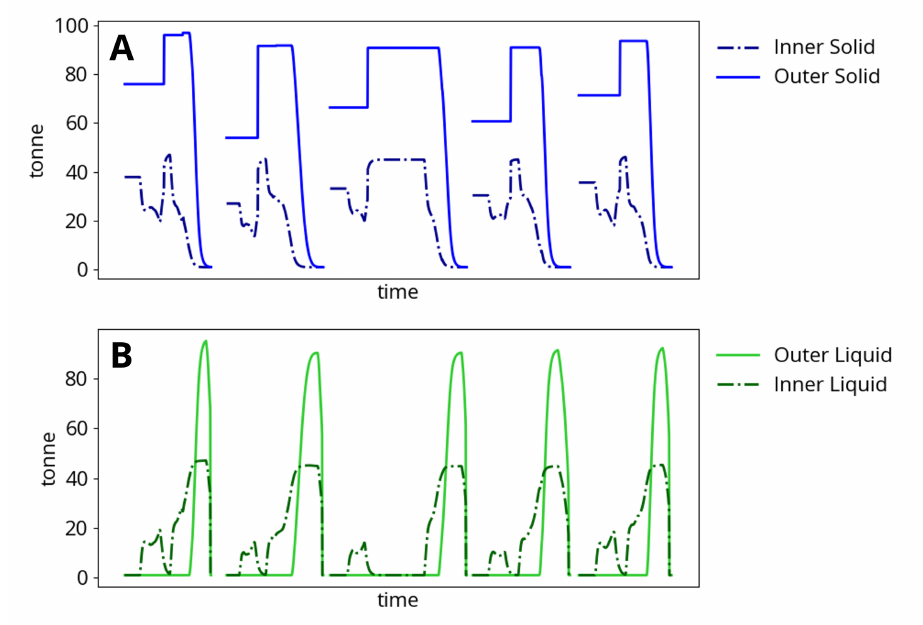
Figure 4. Steel meltdown dynamics and change in ( A ) solid mass and ( B ) liquid mass during five consecutive two-basket heats.